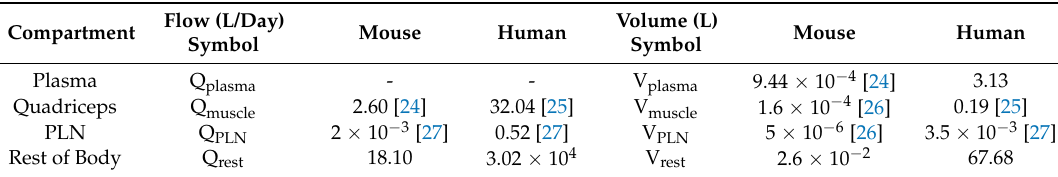
Table 1. Anatomic and physiological parameters used in the physiologically based pharmacokinetics (PBPK) models; PLN: popliteal lymph node 1